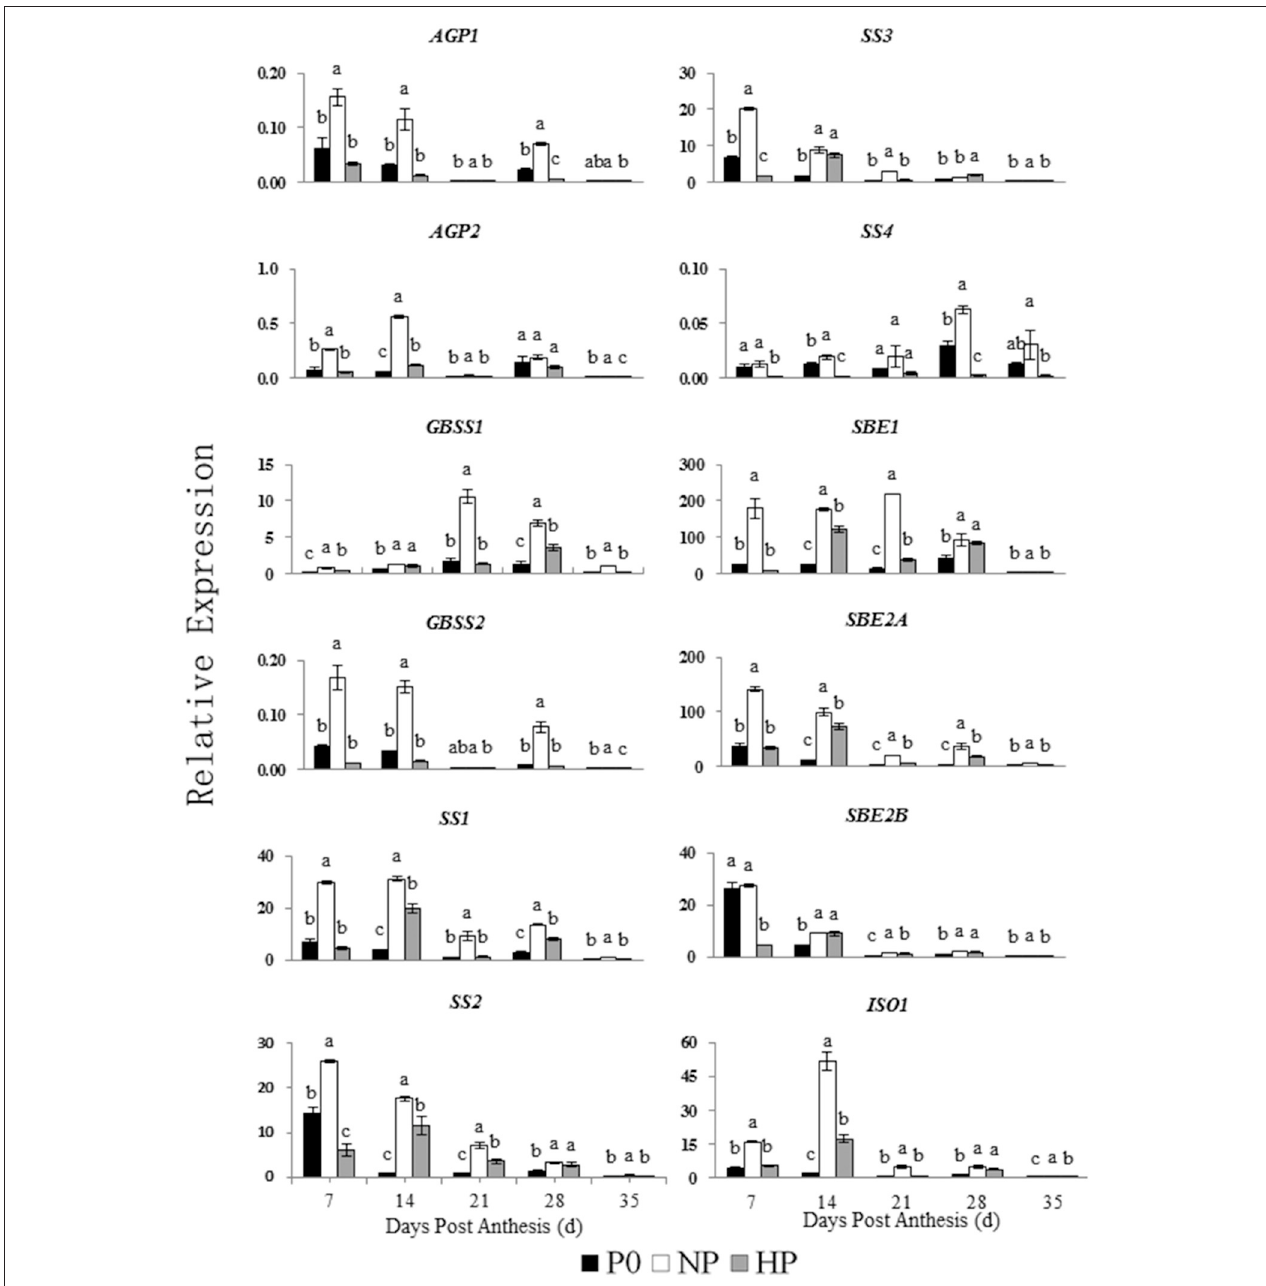
FIGURE 5 | Relative expression of genes involved in starch synthesis in developing wheat endosperm. Values are means ± S.E. of three replications. Columns with different letters are significantly different at p < 0.05. P0: 0kg P ha − 1 ; NP: 46kg P ha − 1 ; HP: 92kg P ha − 1